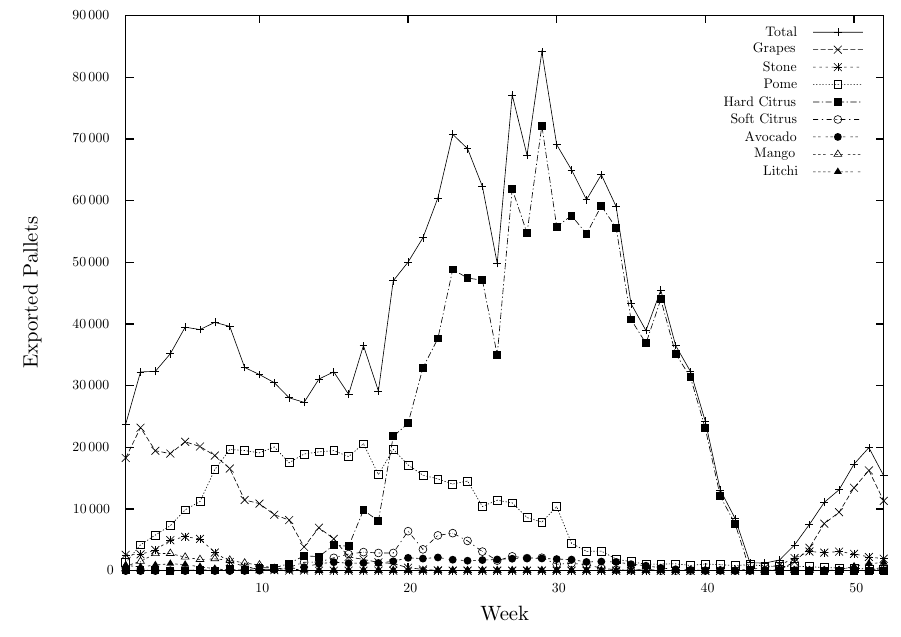
Figure 6: Pallets of fresh fruit exported per week from South Africa during 2003. Note that the deciduous fruit volumes are estimates, that the end-of-year volumes for mangos and litchis are approximations based on 2002 volumes, and that the volumes for citrus and avocados are accurate as reported by the CSA and SAAGA,